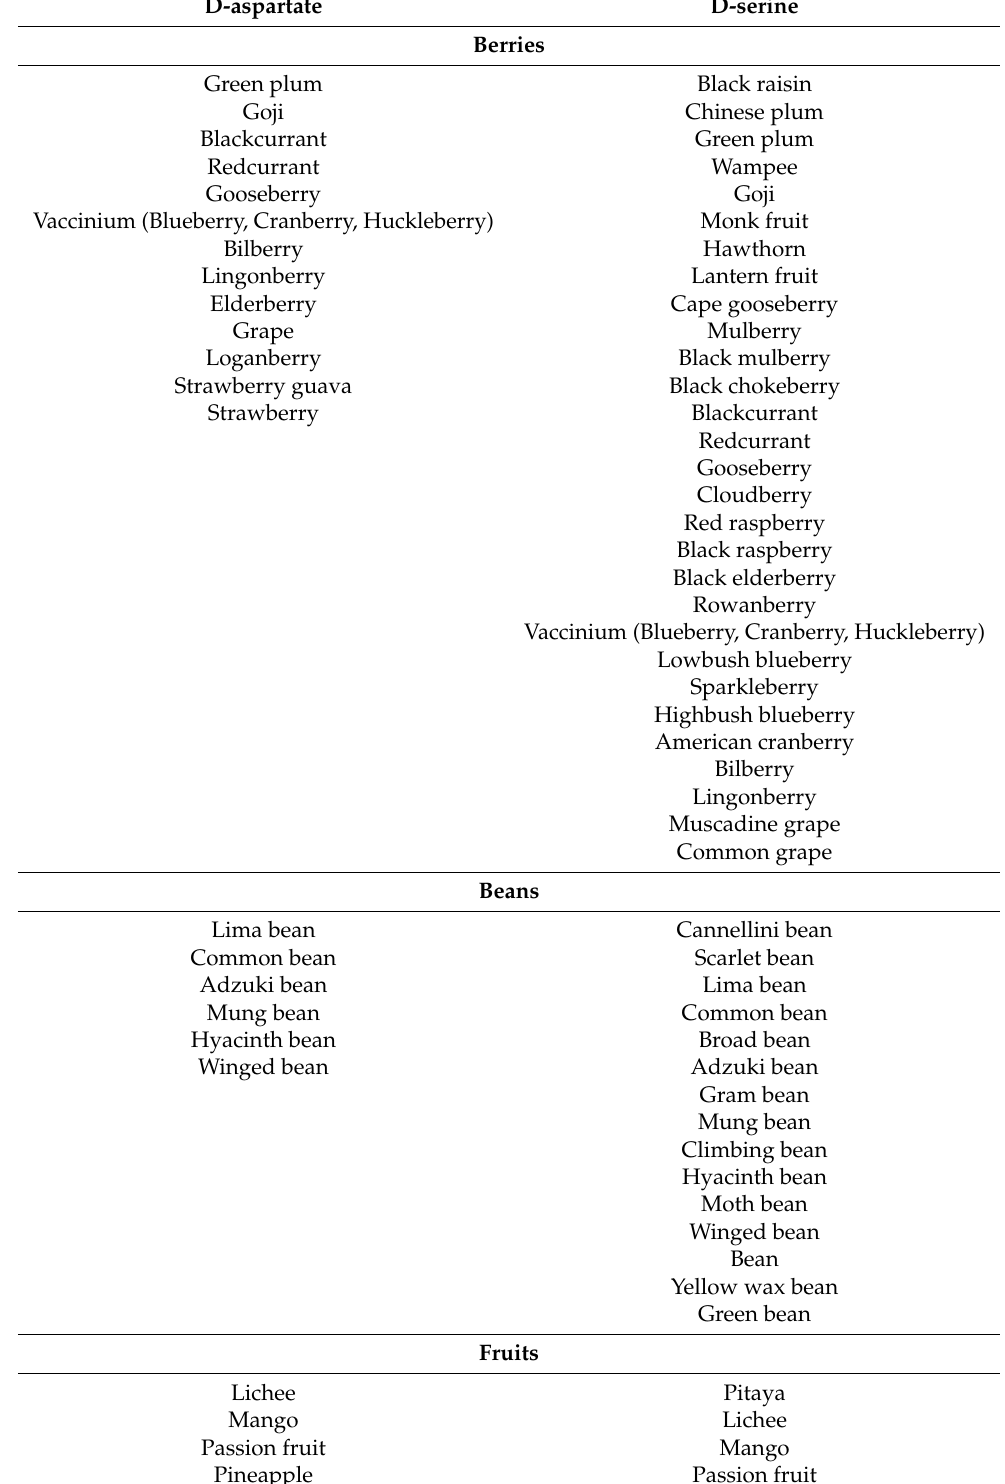
Table 5. Foods rich in D-aspartate and